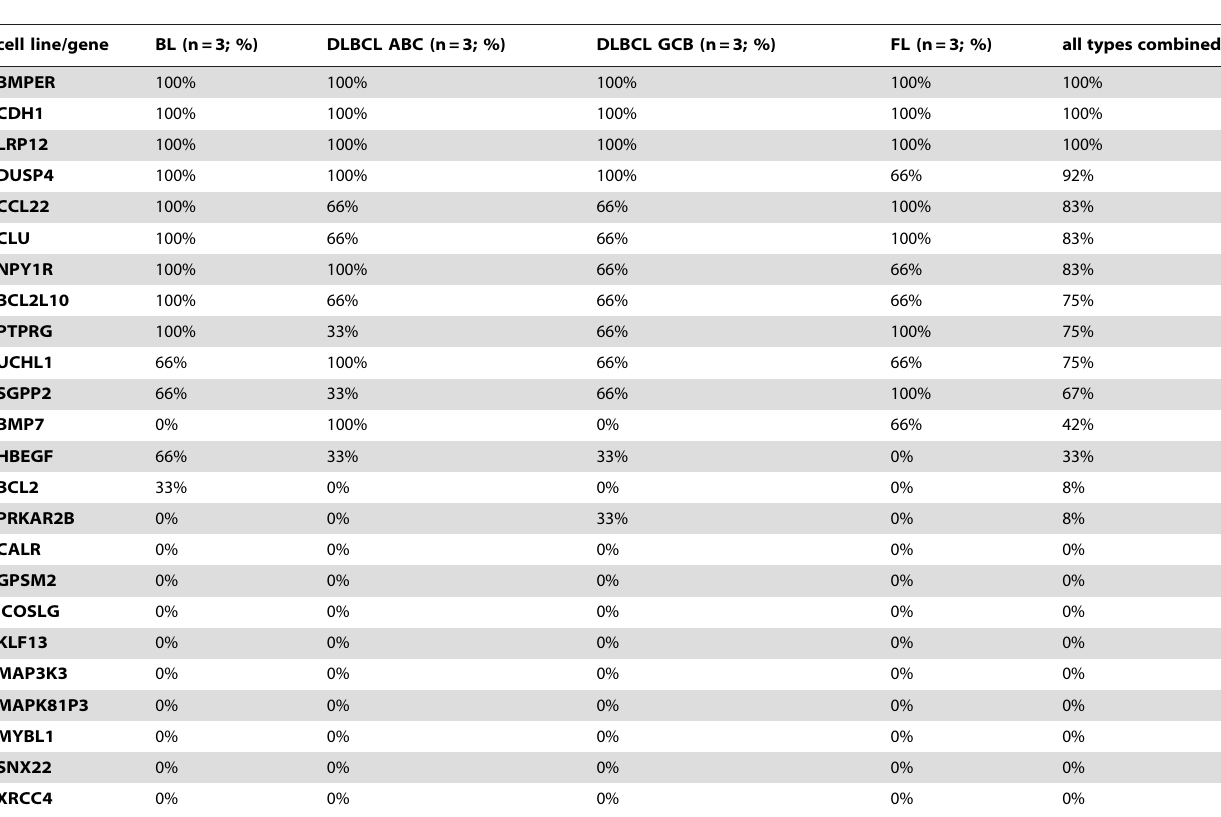
Table 1. Methylation status of candidate genes in 12 B-cell lymphoma cell lines.